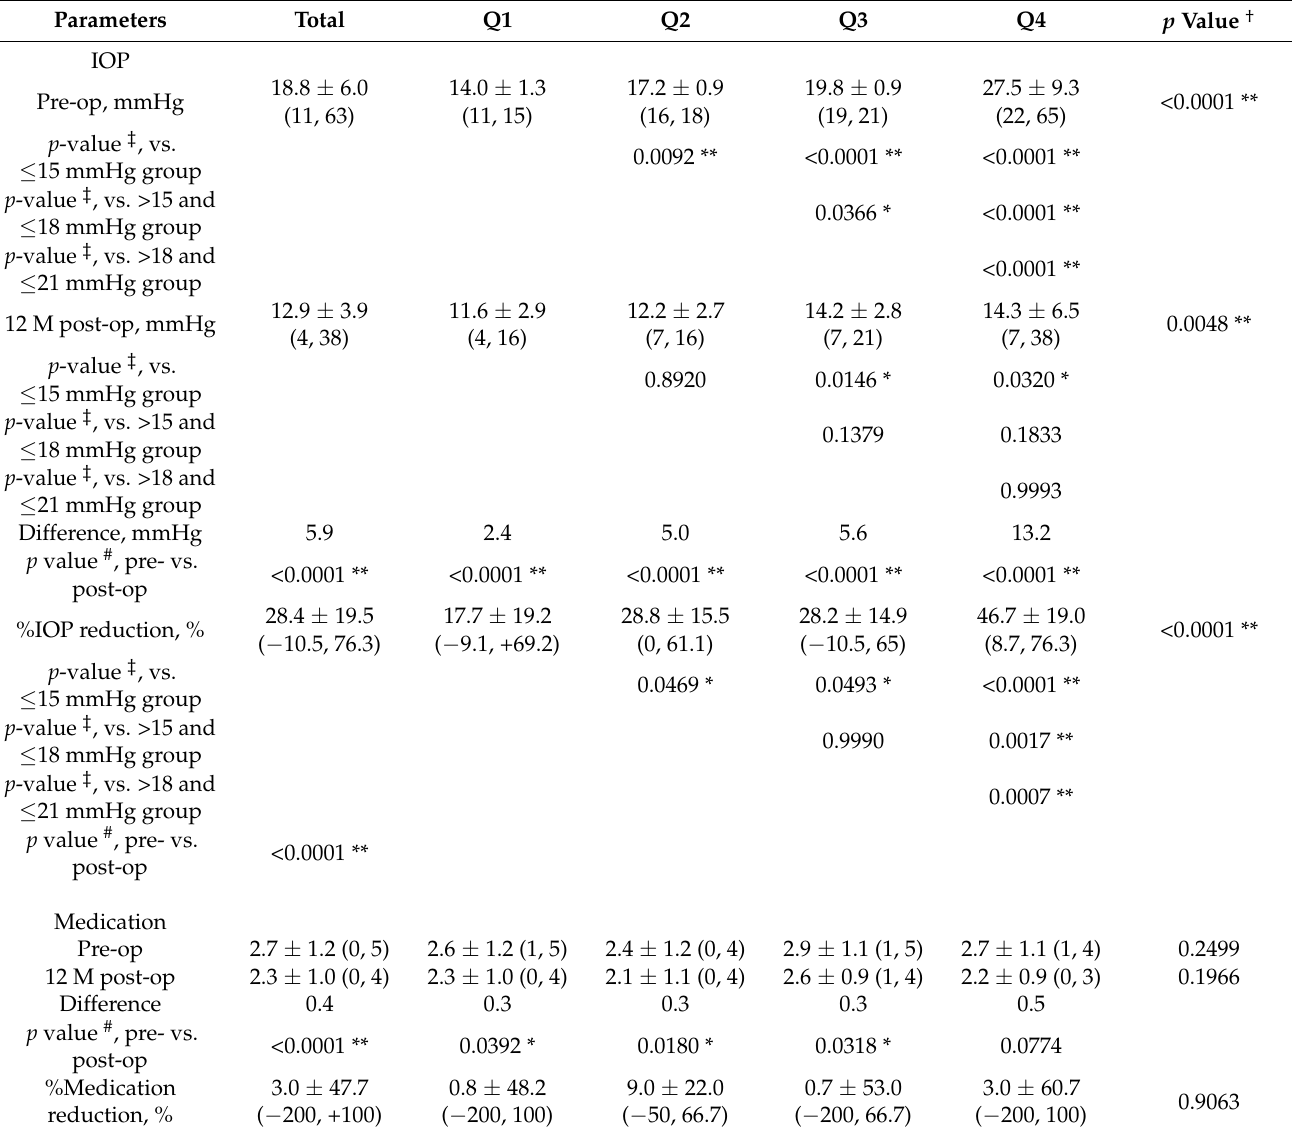
Table 2. Preoperative and 12 months postoperative IOP and